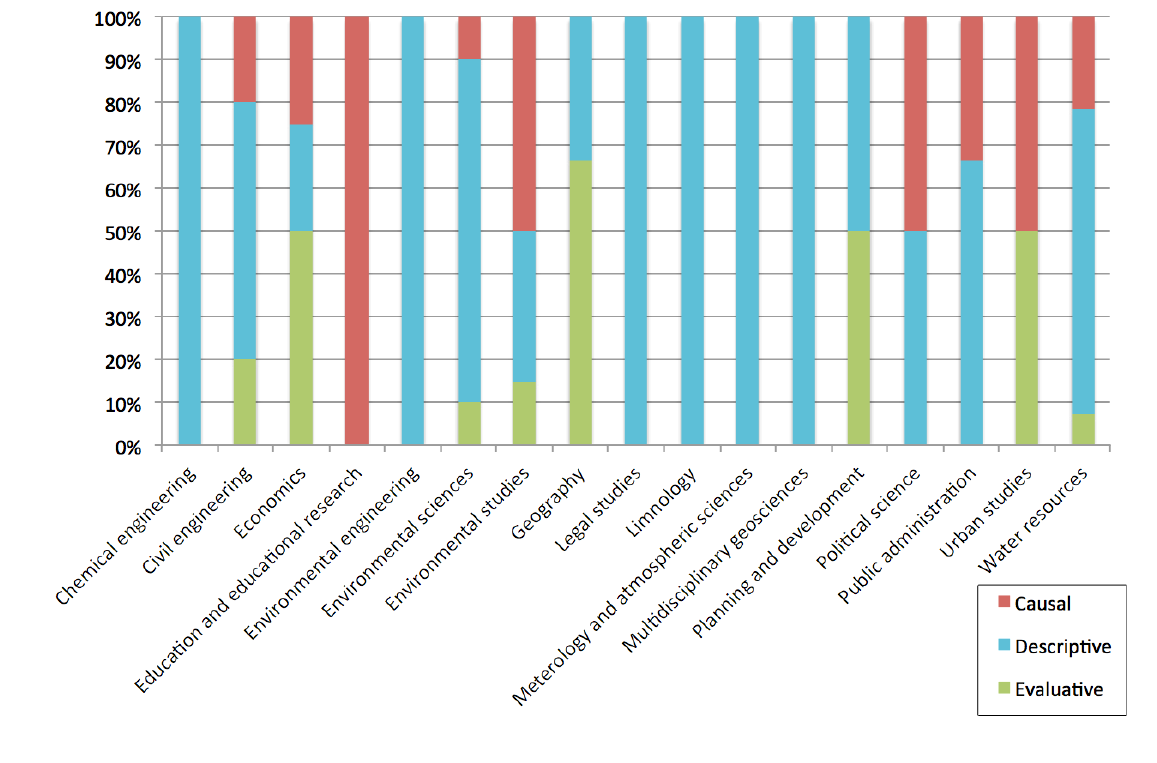
Fig. 6 . Research ambition across Web of Science subject